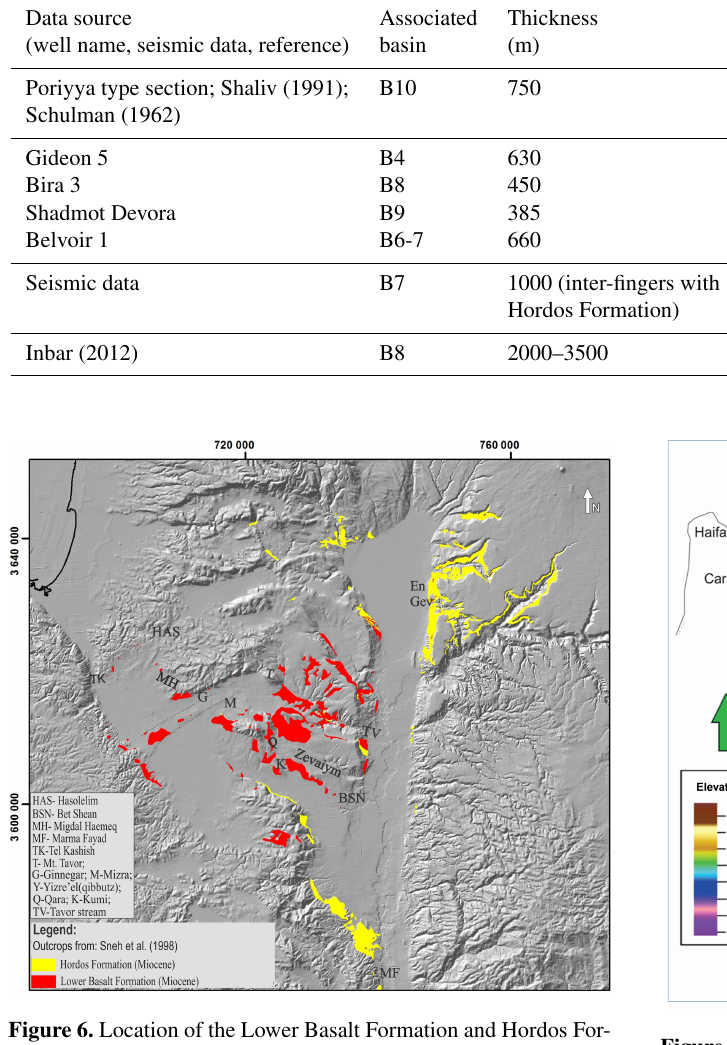
Figure 7. Structural map of the top of the Lower Basalt Formation surface. Note that the lowest areas strike NW. GH – Givat Hamore, MGD – Megiddo, YQN – Yoqne’am, NZR –